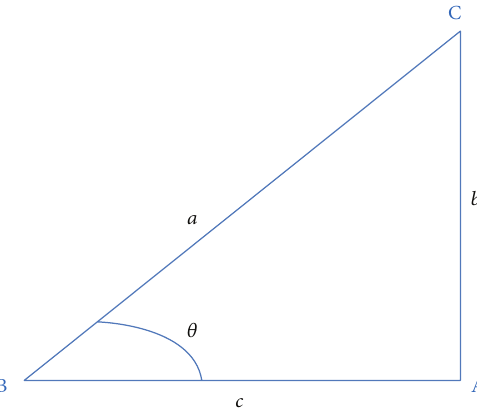
Figure 8: The illustration of the symbols used in (5).